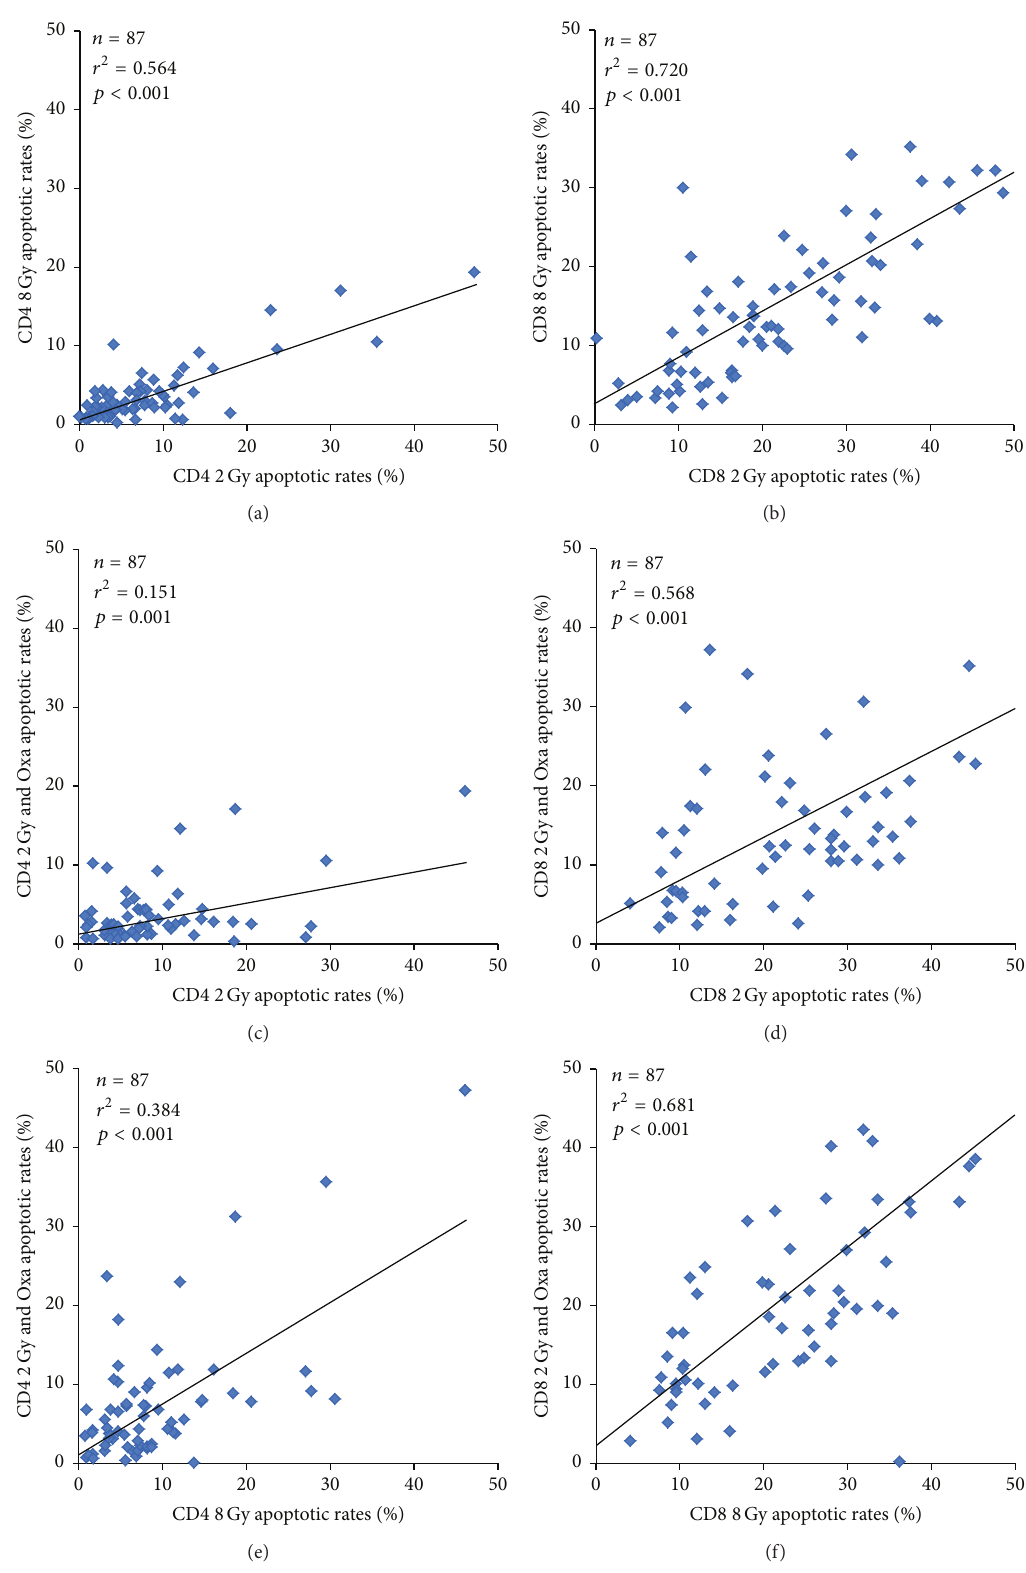
Figure 2: Correlation of 87 rectal cancer patients CD4+ (a, c, and e) or CD8+ (b, d, and f) cells’ apoptotic rates regarding the 2Gy (a and b), 8 Gy (c and d), and combination of 2 Gy and 10 𝜇 g/mL Oxaliplatin (e and f) treatment. The diagrams include the coefficients of determination ( 𝑟 2 ), 𝑝 value, and the trend